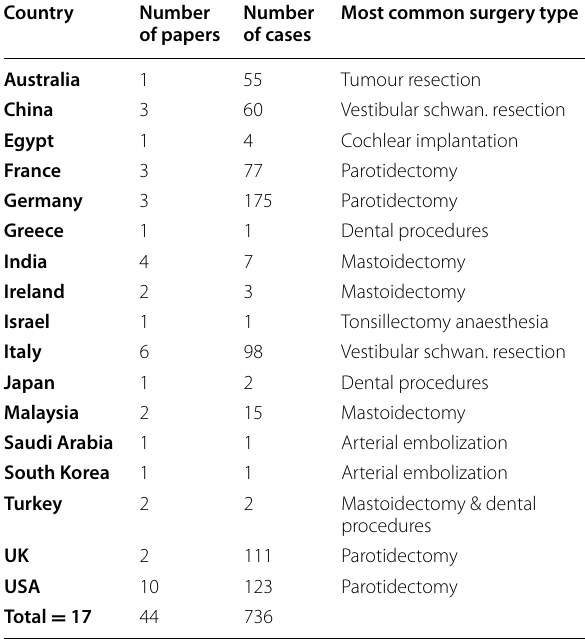
Table 5 Geographical distribution of the FNP cases in the world Country Number Number of papers of